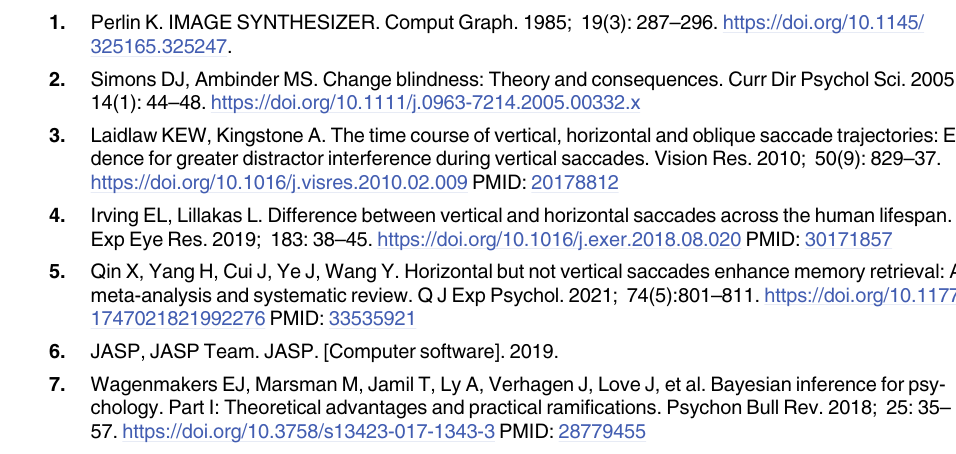
S1 Table. Differences between presentation formats. Inference tests of the individual differ- ences of total misses between conditions, displaying p-values for the statistically significant dif- ferences ( α = .05), ns =